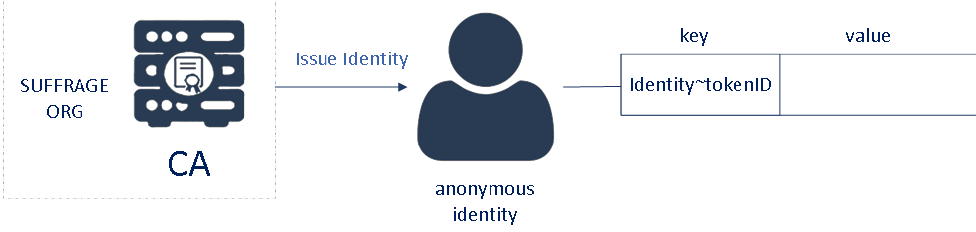
Figure 9. NFT Data Model.